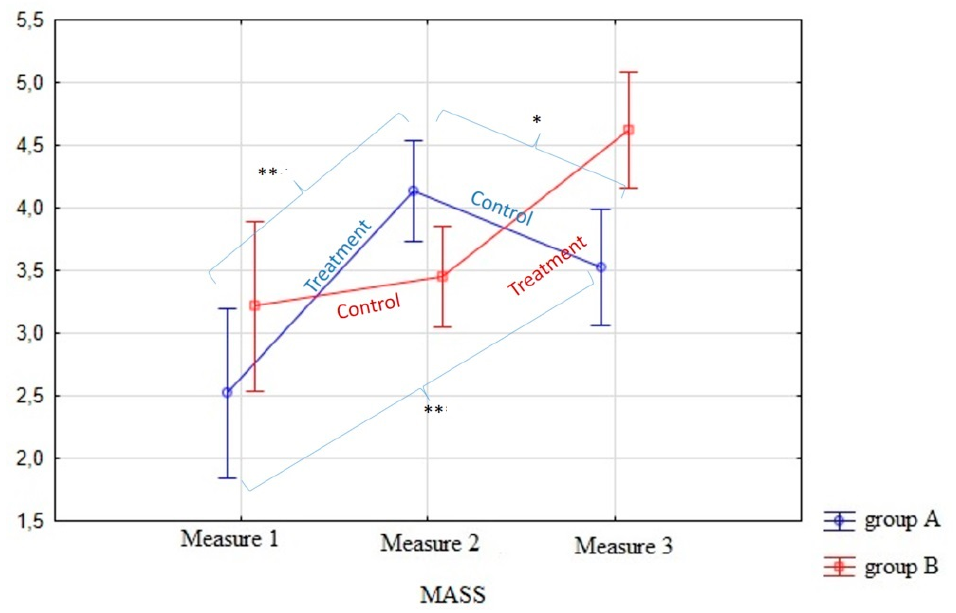
Figure 4. Graphical representation of MASS test results (*) p < 0.05; (**) p < 0.01.